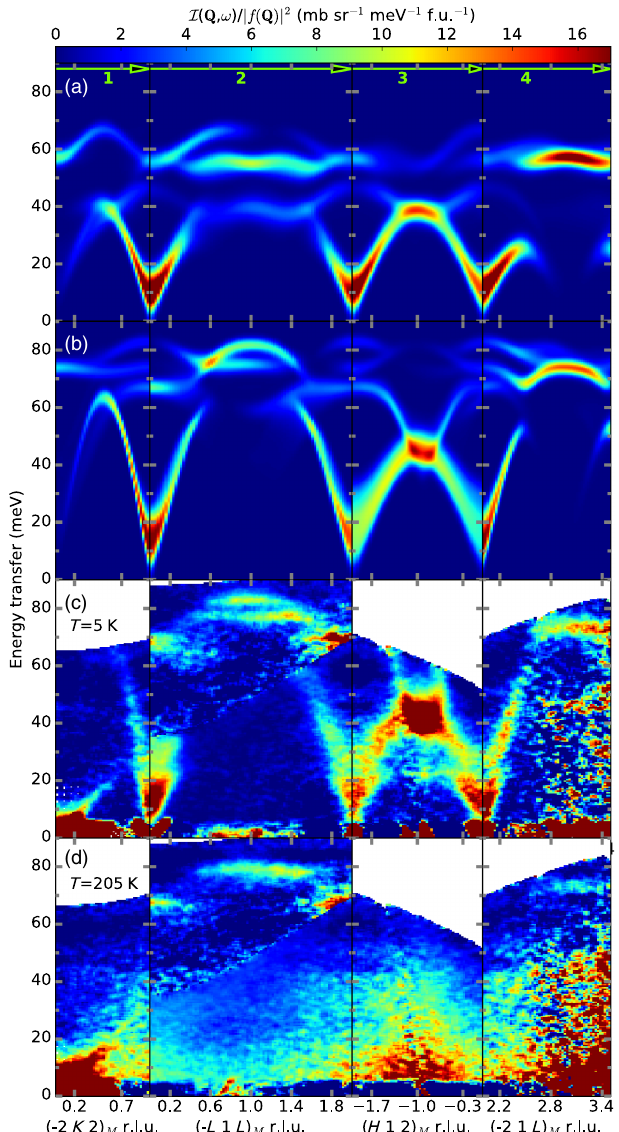
FIG. 3. Neutron scattering intensity associated with spin waves along four high-symmetry directions marked in Fig. 2 using (a) DFT calculated exchange constants for ð V 0 (b) exchange constants obtained from fits to the data. (c),(d) INS cross section measured at 5 and 205 K ( E from multiple Brillouin zones were assembled to cover the largest possible range of energy transfer. The data were divided by the squared magnetic form factor for presentation. Also, an incoher- ent background determined by azimuthal averaging of the same data was subtracted (Appendix A